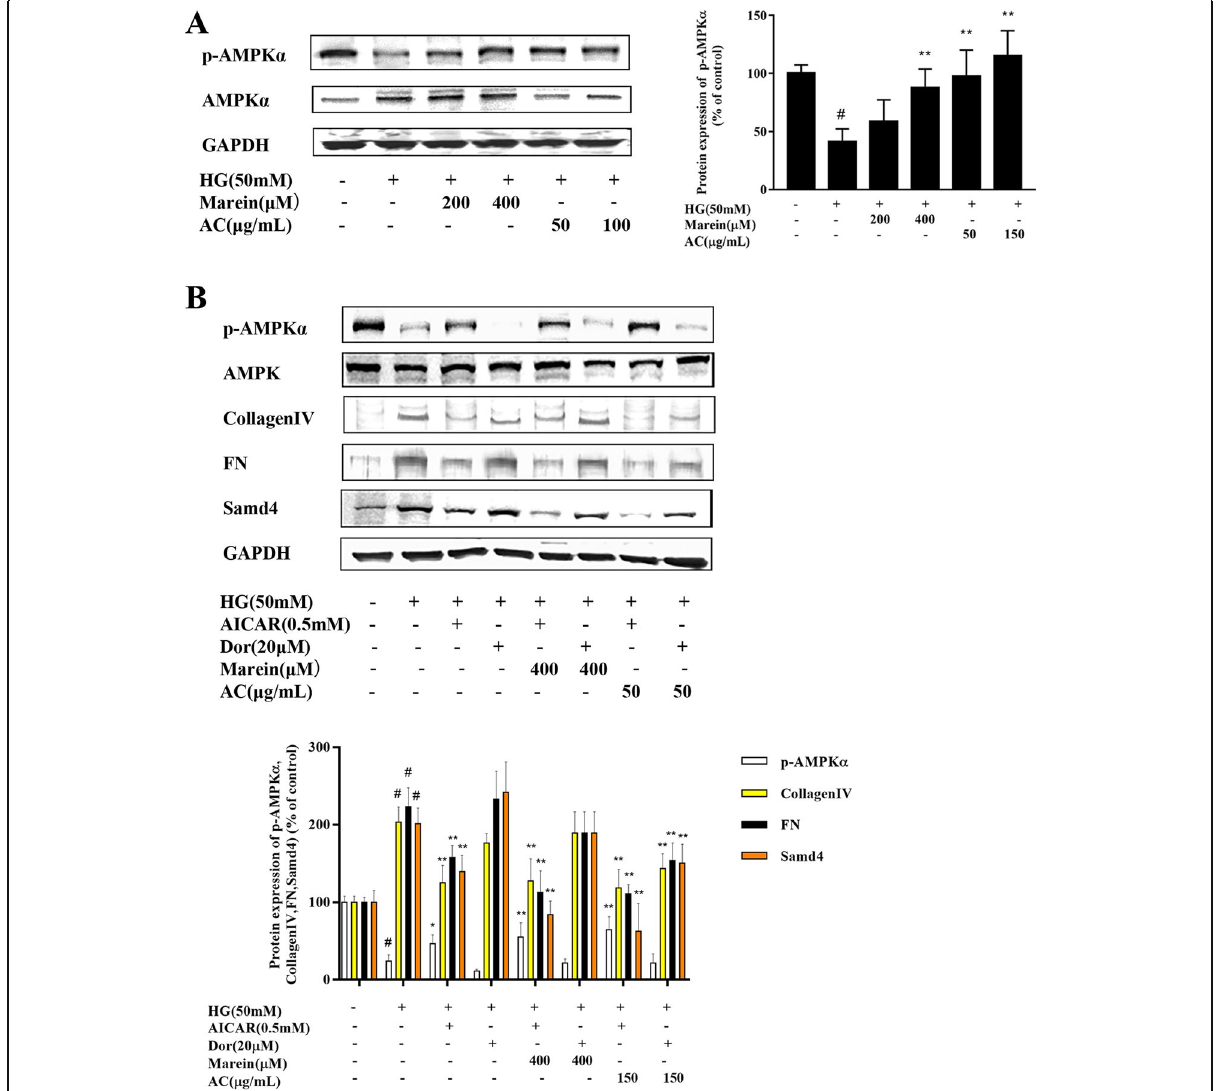
Fig. 5 a Effect of AC and marein on p-AMPK expression in HBZY-1 cells by western blots. b HBZY-1 cells were pretreated with AC and marein for 2 h, and then stimulated with AICAR, an AMPK activator and Dorsomorphin (Dors) an AMPK inhibitor followed by NG or HG exposure for 24 h. Equal amounts of lysate were subjected to western blotting analysis to determine p-AMPK, collagen IV, FN, and Smad4 proteins. Note: Values were expressed as the mean ± SD, n = 4. # P < 0.01 versus normal group; * P < 0.05 versus control group; ** P < 0.01 versus control